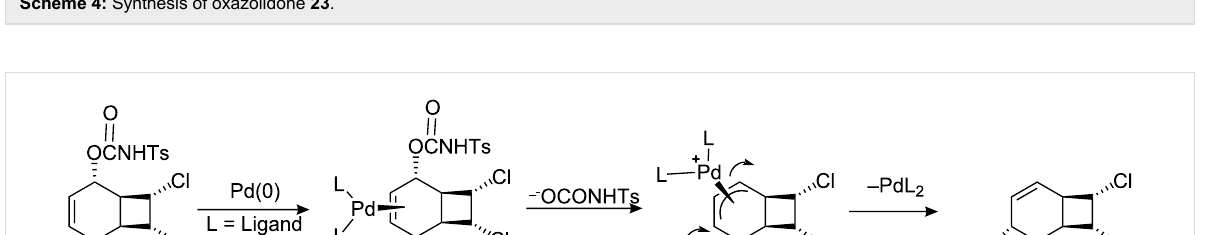
Scheme 4: Synthesis of oxazolidone 23 .